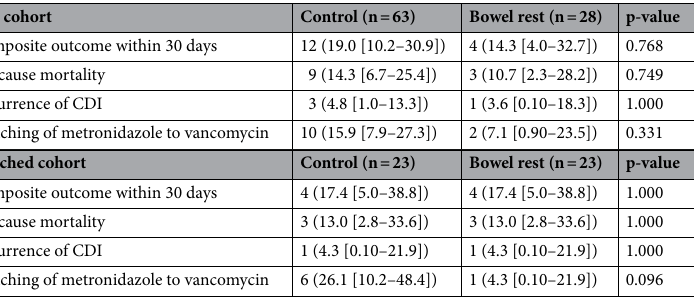
Table 3. Summary of outcomes in the study cohort. Data are number (% [95% confidence interval]). CDI , Clostridioides difficile infection.